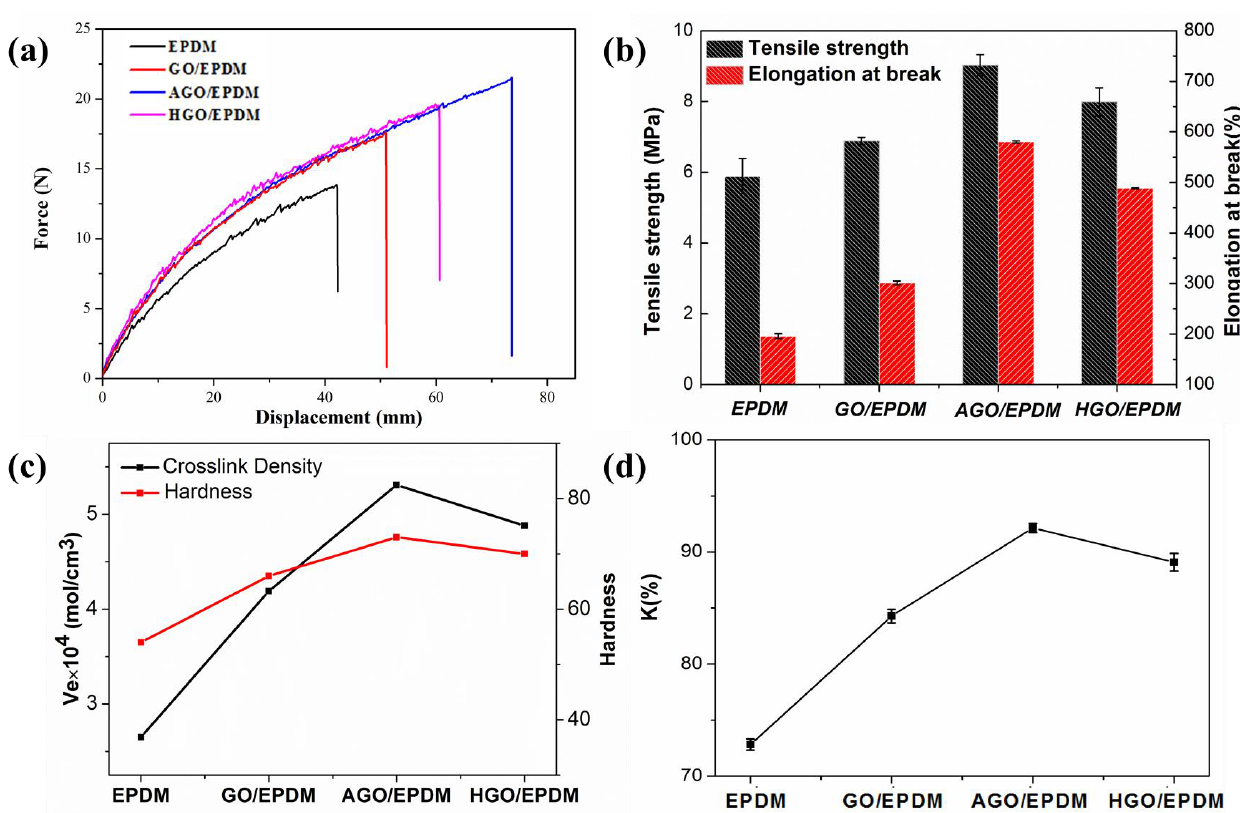
Figure 9. ( a ) The strain–stress curves, ( b ) tensile properties, ( c ) crosslink density and hardness, and ( d ) the mechanical performance retention rate of the EPDM insulations.